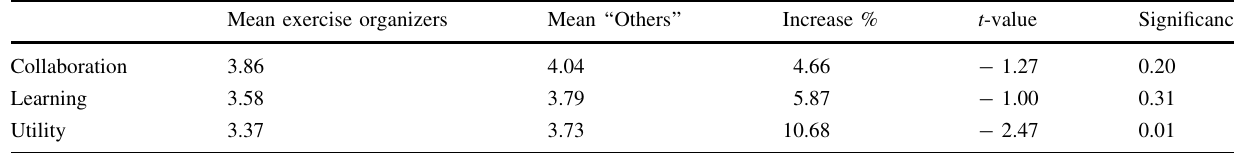
Table 2 Mean results and t-values of the exercise organizer and non-organizer groups for collaboration, learning, and utility Mean exercise